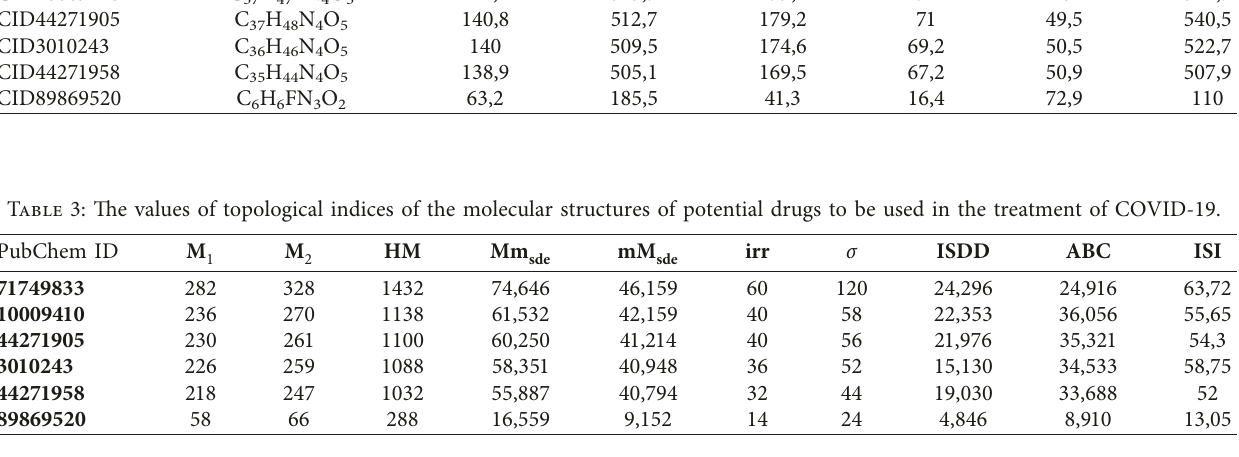
The molecular graph of CID44271905 has 46 vertices and 49 edges. Its edges can be partitioned as | E